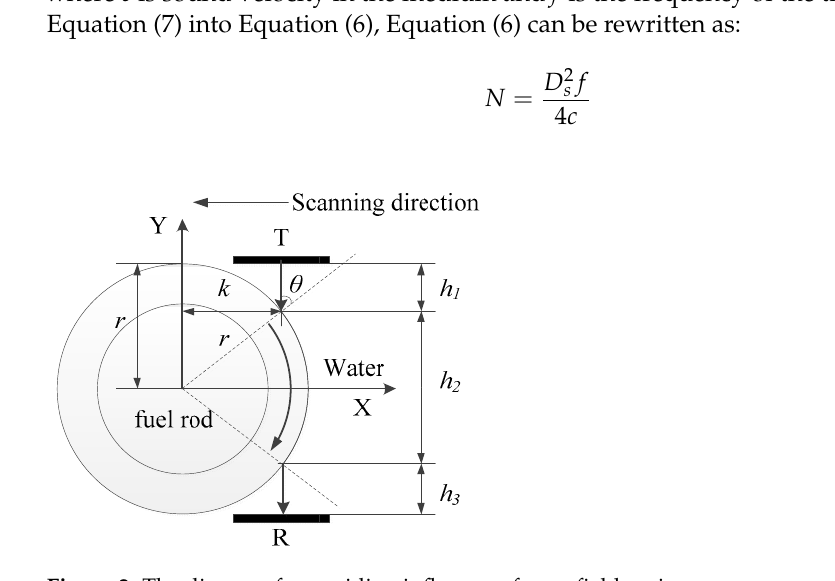
Figure 3. The principle of inspection. 2.2.3. The proposed algorithm The scanning direction is from right to left. Since the tube is symmetrical along the Y-direction, the signal in the scanning process is also axisymmetric. Therefore, taking the right side of the rod into consideration, the incident angle of ultrasonic wave θ will change from 90° to 0°. The A-scan signal in the scanning process can be divided into 3 parts. At first, the fuel rod is out of the ultrasound range. The transmitted wave will be received by the receiving transducer completely. The signal at this time has been taken as the reference position called lateral wave as the red line, as shown in Figure 4. Secondly, the plate wave is excited as the transducer’s movement. At this moment, the received signal is compli- cated. Because of that, not only the plate wave that passes through the rod can be received, but also the wave passing through the water column. In addition, the different wave modes will also be received. In addition, the amplitude of the plate wave passing through the failed rod is lower than that non-failed rod, as the green and purple lines in Figure 4 show. At last, when the transducer moves to the center of the tube, most of the transmitted wave will be blocked. Therefore, the lateral wave was the lowest, as the orange line shows in Figure 4.